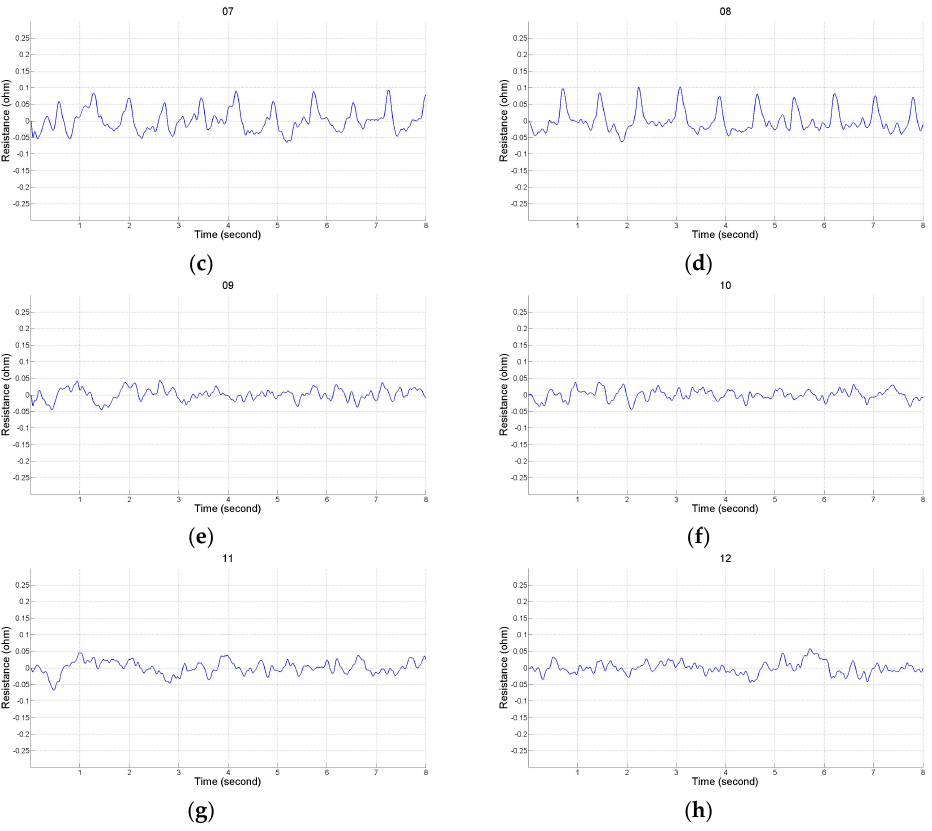
Figure 5. The electrode array is in the vertical direction. ( a ) T 1 , T 2 are IV and I, R 1 , R 2 are II and III; ( b ) T 1 , T 2 are IV and II, R 1 , R 2 are I and III; ( c ) T 1 , T 2 are 𝒟 and 𝒜 , R 1 , R 2 are ℬ and 𝒞 ; ( d ) T 1 , T 2 are 𝒟 and ℬ , R 1 , R 2 are 𝒜 and 𝒞 ; ( e ) T 1 , T 2 are IV and II, R 1 , R 2 are II’ and III’; ( f ) T 1 , T 2 are IV and II, R 1 , R 2 are I’ and III’; ( g ) T 1 , T 2 are IV and I’, R 1 , R 2 are II’ and III; ( h ) T 1 , T 2 are IV and II’, R 1 , R 2 are I’ and III.